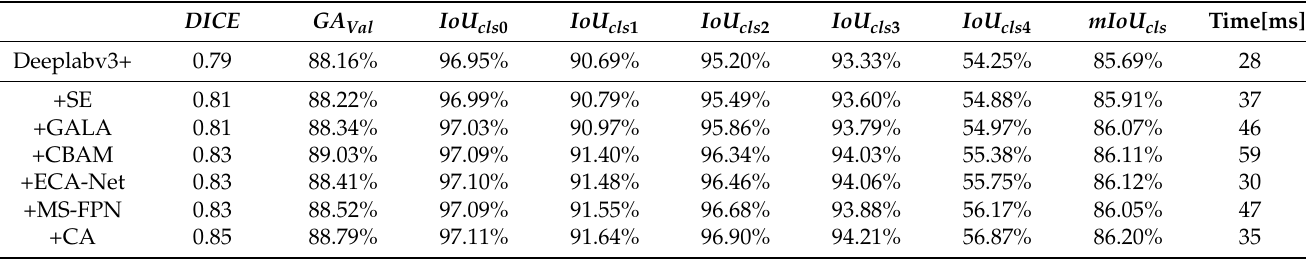
Table 1. Comparison of improvement effects of different attention